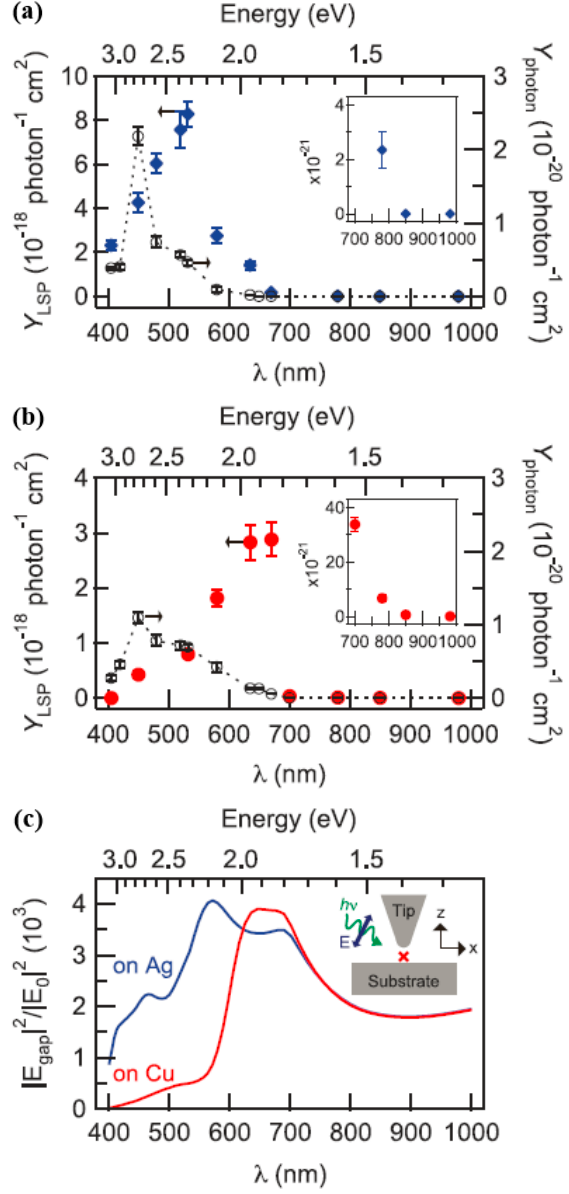
Figure 14. Wavelength dependence of the plasmon-induced chemical reaction and of the plasmonic electric field. Wavelength dependence of Y LSP of ( CH 3 S ) molecules on ( a ) Ag(111) (blue diamonds) and ( b ) Cu(111) (red circles). Insets in ( a ) and ( b ) show Y LSP for 700 to 980 nm. Each data point represents the average of results from six trials. The photodissociation yields without the excitation of the LSP [ Y photon , previously reported in [26]] (black circles) are also shown. The yield is determined from k divided by the number of incident photons per second (~6.0 × 10 16 to 6.5 × 10 16 photons cm − 2 · s − 1 for both plasmon-induced dissociation and photodissociation). Error bars indicate standard deviation (SD). ( c ) Calculated electric field intensity for a 1-nm gap between an Ag tip and the metal substrates under p-polarized light. The simulated point is z = 0.1 nm above the substrate surfaces and x = 0 nm. Adapted from